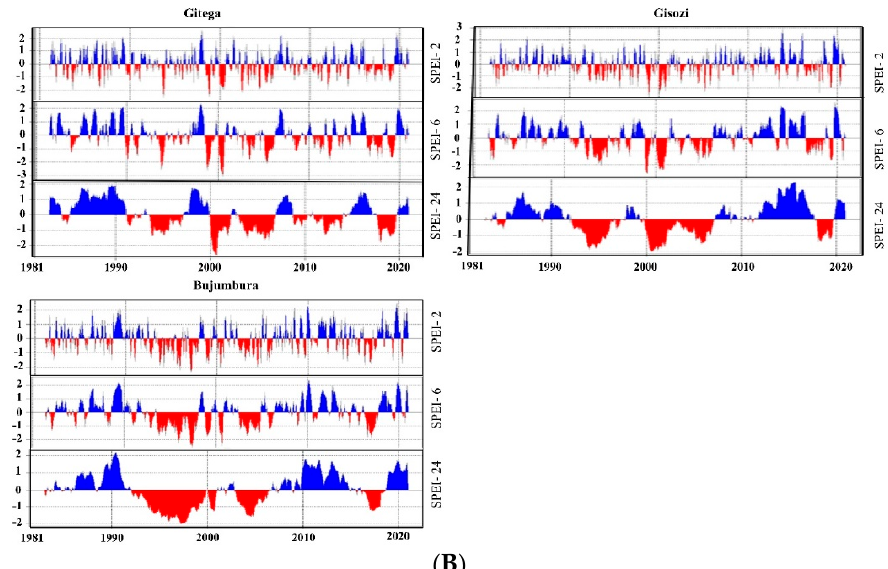
Figure 5. SPEI values illustration of dry (in red) and wet (in blue) conditions in Burundi. ( A ) The northern, eastern, and southeastern parts; ( B ) the central western parts.